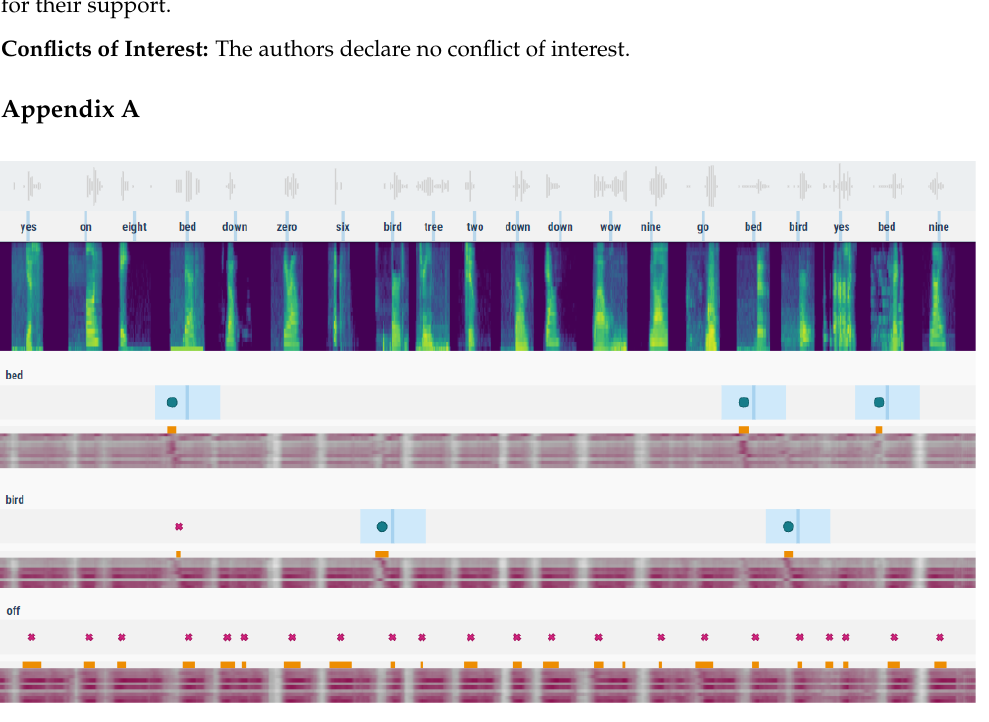
Figure A1. Example of a detection report for the Google speech embedding model with standard detection settings, without post-processing. The upper part shows a timeline of the Speech Commands mixture file with a corresponding spectrogram visualisation. The lower part contains an excerpt from the detection reports for three selected keywords. Blue regions indicate actual keyword occurrences with an acceptable detection collar. The main lanes below each keyword show similarity values for each of the provided keyword patterns (i.e., multiple rows per keyword). Darker values correspond to closer matches. Desaturated parts indicate discarded fragments with distances above the threshold. Orange markers denote possible detections. If a sufficiently long streak of detections is generated, actual occurrences are emitted—denoted either by a dot (correct detection) or a cross sign